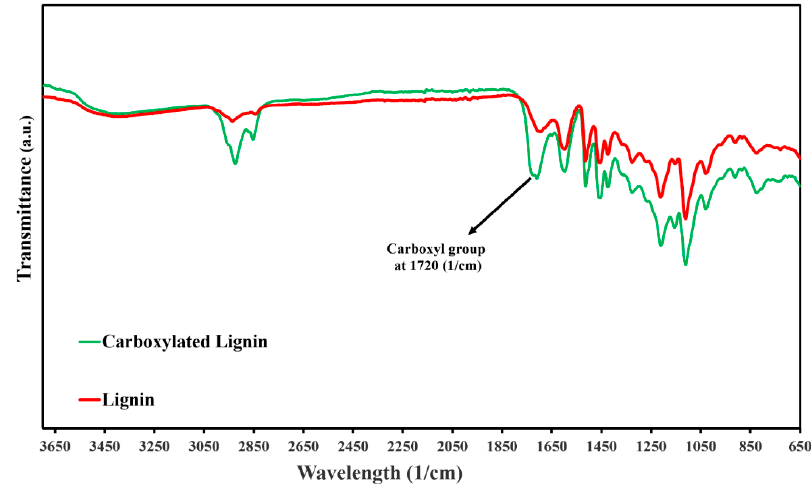
Figure 2. Fourier-transform infrared spectroscopy (FTIR) spectra of lignin (red) and carboxylated lignin (blue).